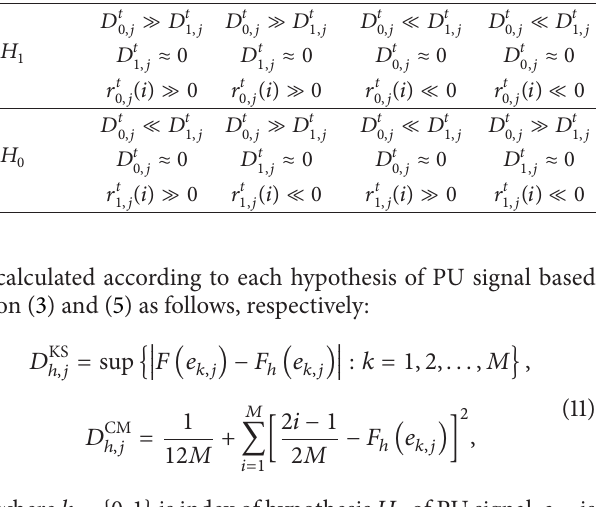
Table 1: Reputation ranges according to each type of CUs. Status of PU